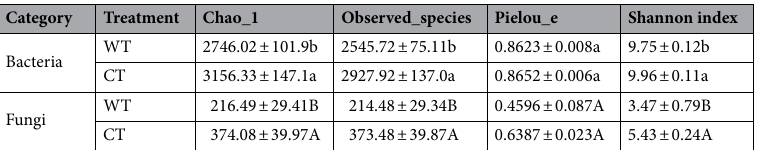
Table 2. Estimation of bacteria and fungi community diversity under cultivated cultivations (CT) and wild growth conditions (WT).